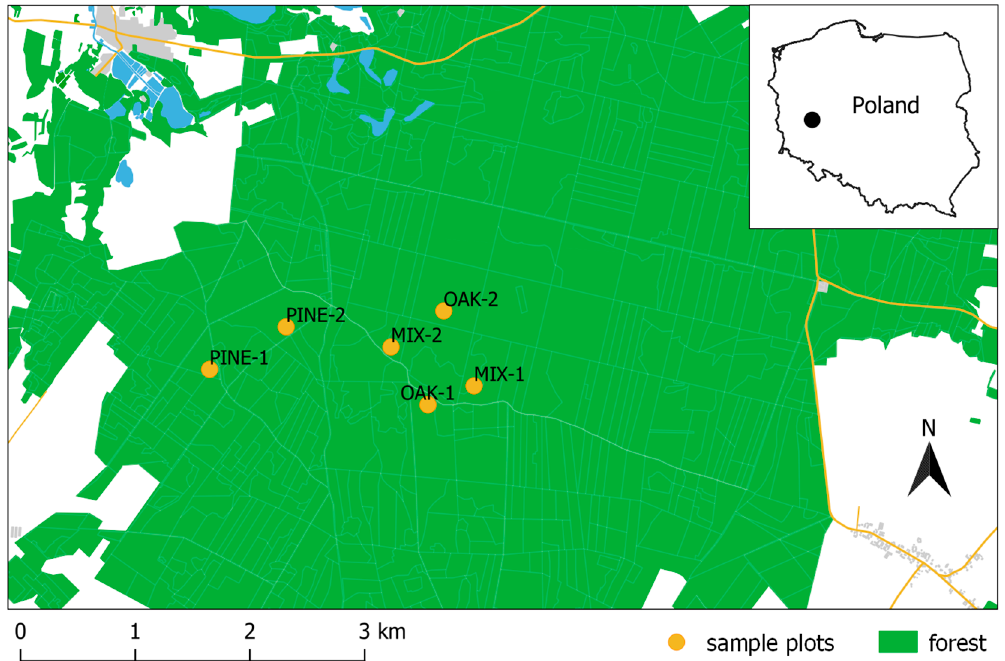
Figure 1. Distribution of sampled stands (see Table 1 for stand description; source of spatial data: OpenStreetMap.org and https://www.bdl.lasy.gov.pl, accessed on 12 November 2021).